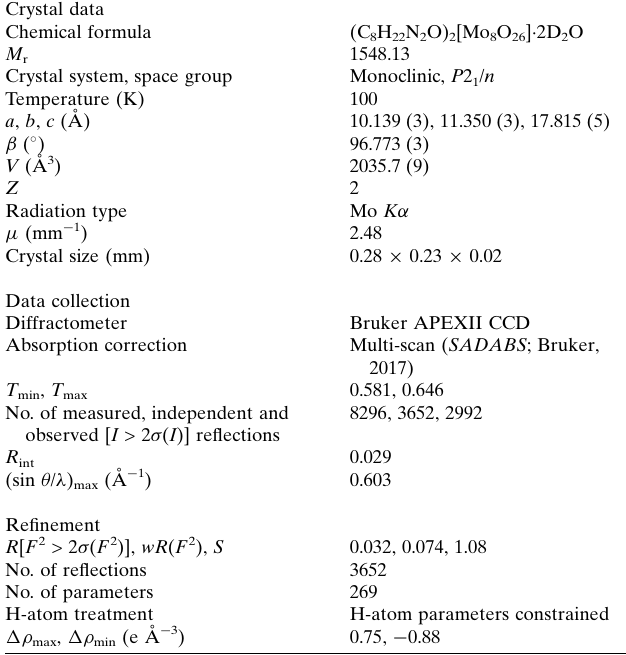
Table 3 Experimental details. Crystal data Chemical formula